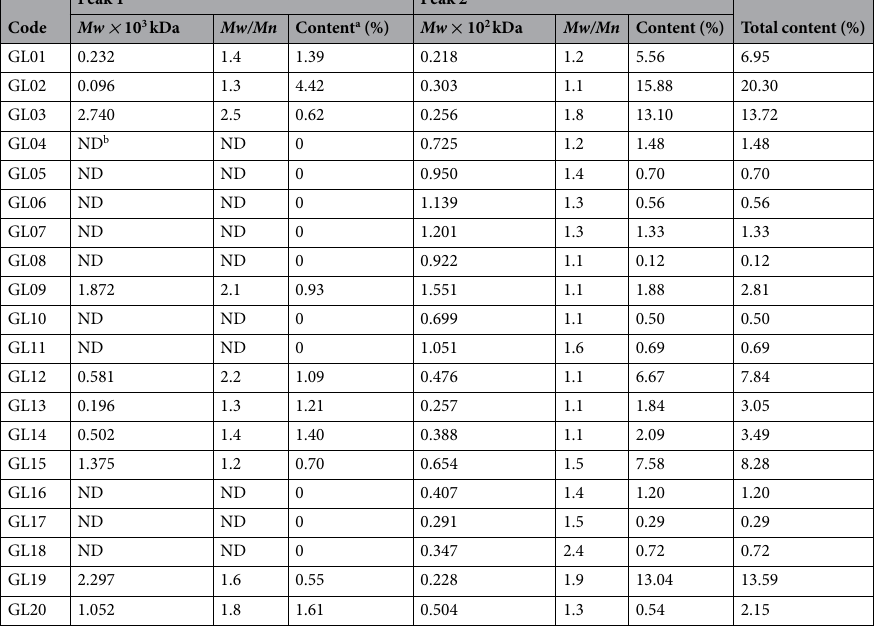
Table 2. Molecular weights and contents of polysaccharides in G . lucidum dietary supplements after α -amylase digestion. a Content of polysaccharides in the raw material, all data were the average of two measurements with coefficient of variation < 5%; b Not detected in the sample; Peaks were the same as in Fig. S4; Sample codes were the same as in Table